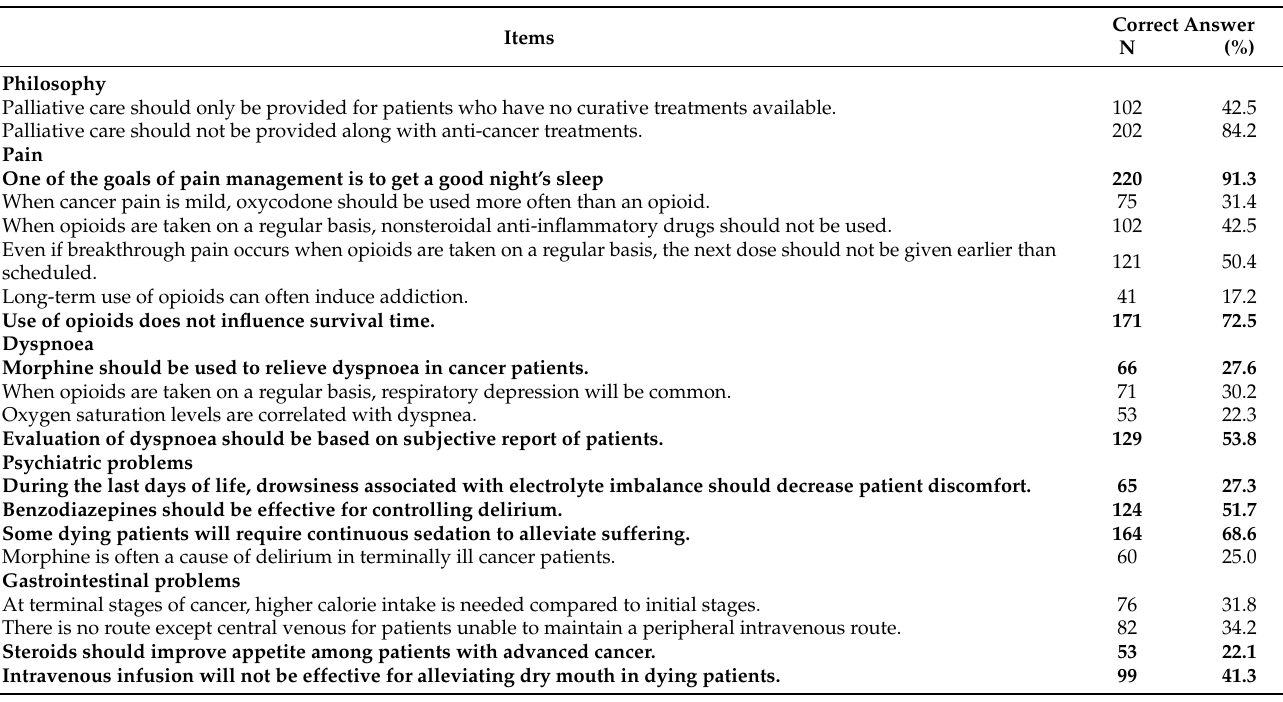
Table 2. Results of Palliative Care Knowledge Test